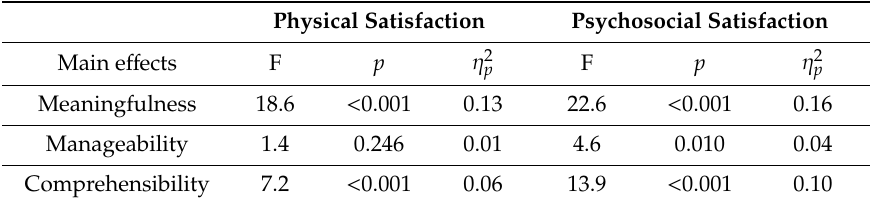
Table 5. E ff ects of the indicators for sense of coherence (SOC) on perceived physical and psychosocial work satisfaction ( n = 246).